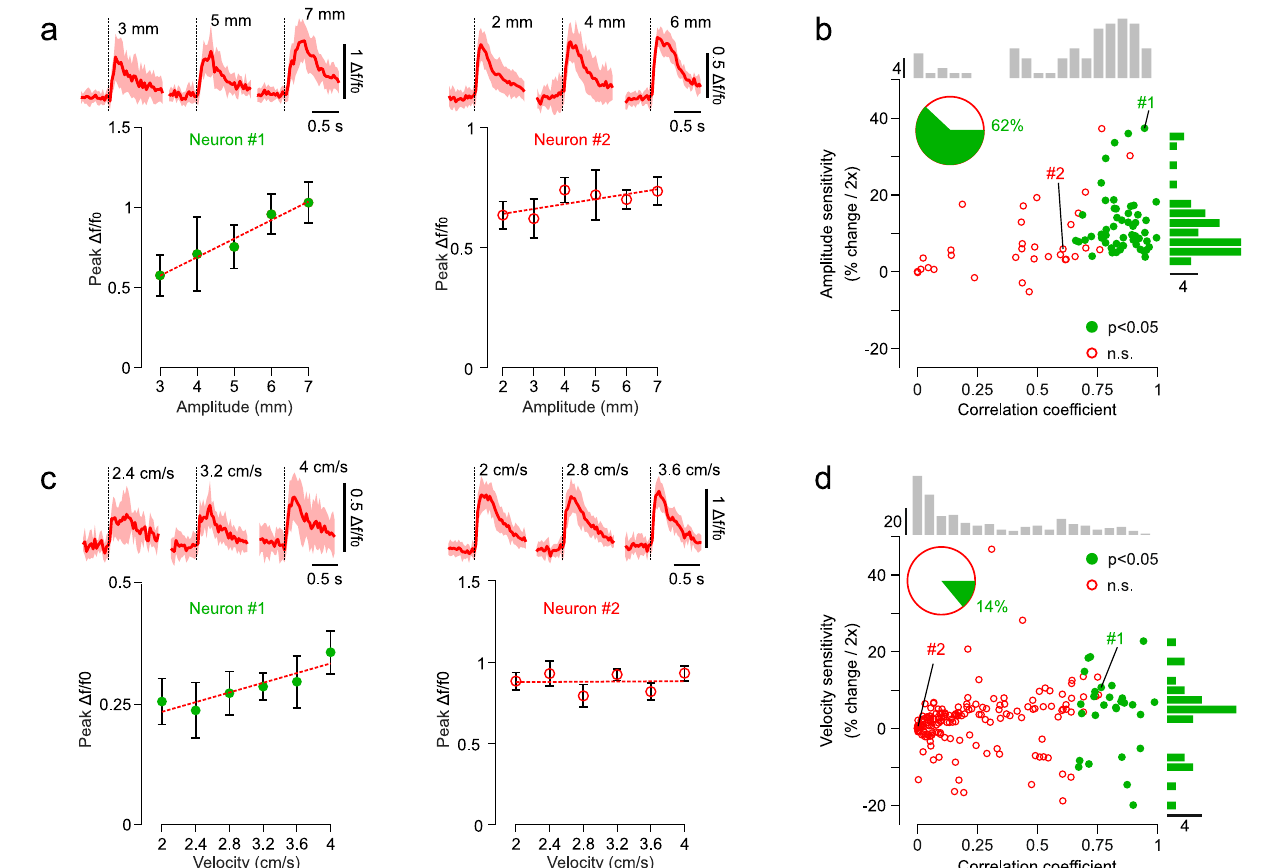
Fig.7|AmplitudeandvelocitytuninginfS1.a Mean(±s.d.)peakresponsesoftwo example neurons tuned by (left) and insensitive (right) to displacement amplitude (dotted lines are linear regression fi ts, at least N =5 repetitions per tested ampli- tude). Top, Δ f/f 0 mean (±s.d.) traces of the same neurons for three different amplitudes. b Amplitude sensitivity (% change in peak response for a doubling of movement amplitude) as a function of correlation coef fi cient (peak response vs. movement amplitude) of neurons tested with varying amplitudes. Top histogram: